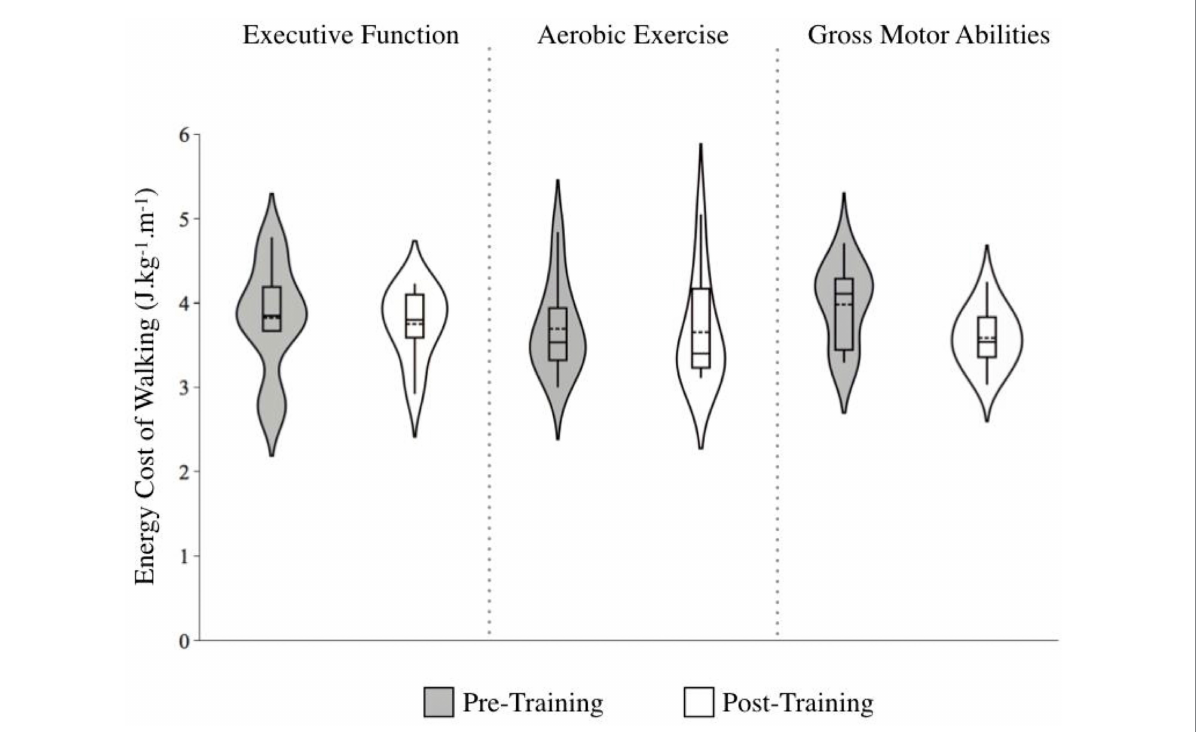
FIGURE 7 Energy cost of walking (ECW) before and after training across training groups. Note. Lower scores indicate more efficient walking. The length of each curve represents the range of scores, the width represents the frequency of data points in each region, the solid line within each boxplot represents the median, and the dotted line represent the mean. Improvements in ECW were found following gross motor abilities training ( g = − 0.94 [large effect] ∆ = − 11.0%), although the interaction effect was not